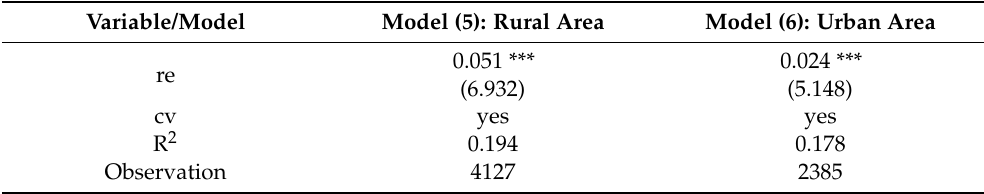
Table 5. Results of heterogeneity